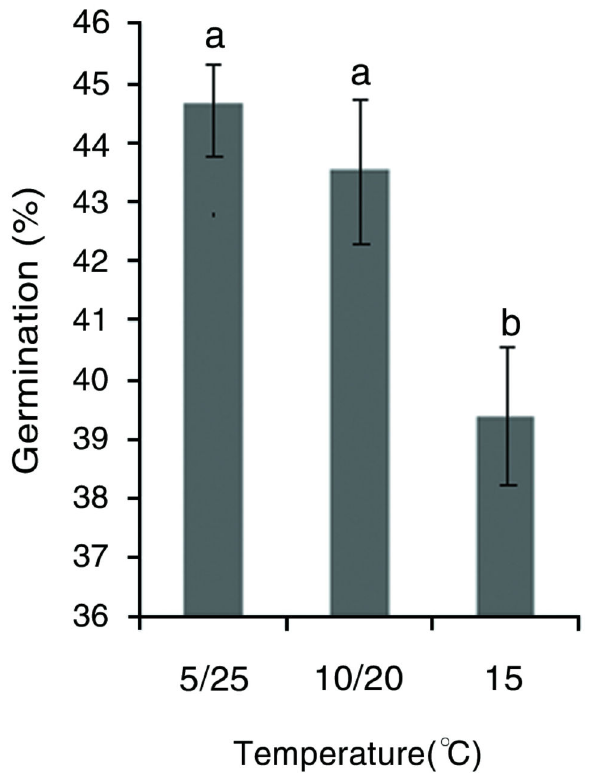
Figure 1. Effect of temperature fluctuation on germination percentage of 445 species from the eastern Tibet Plateau of China.